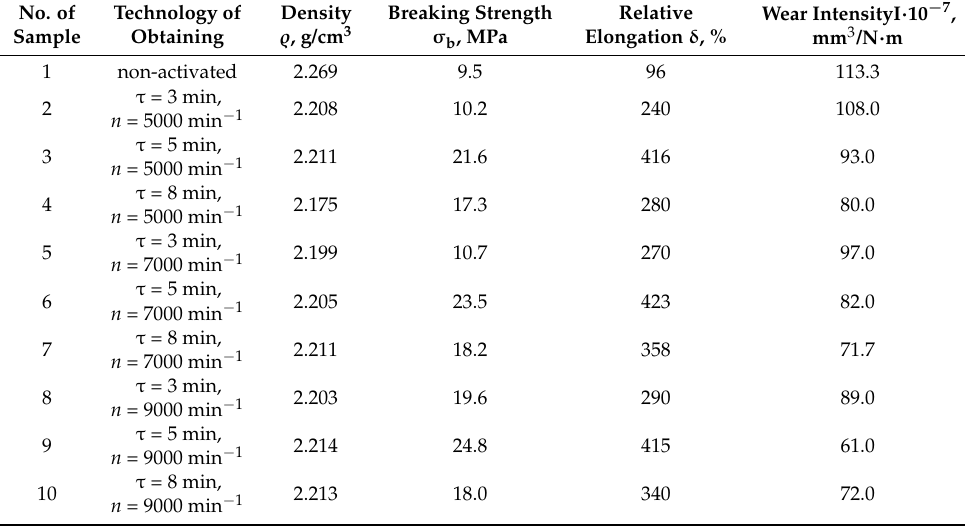
Table 4. Effect of PTFE mechanical activation on physical and mechanical and tribotechnical properties. No. of